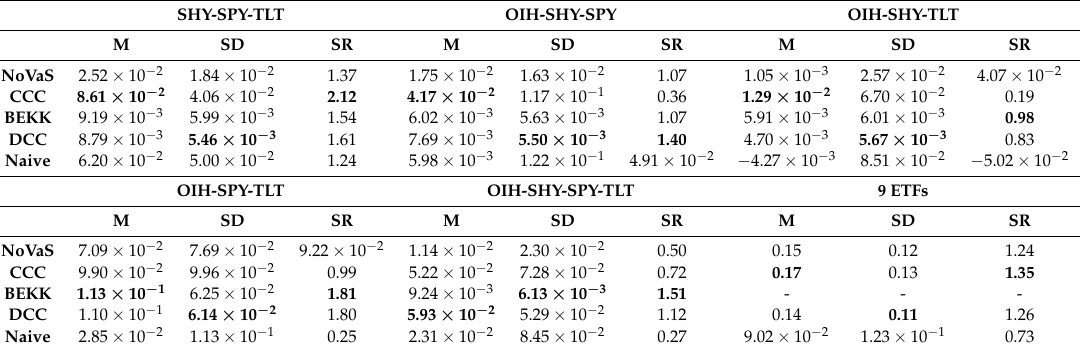
Table 13. Mean (M), standard deviation (SD) and Sharpe ratio (SR) of portfolio returns with weekly rebalancing and with weights computed on 1/3 of available